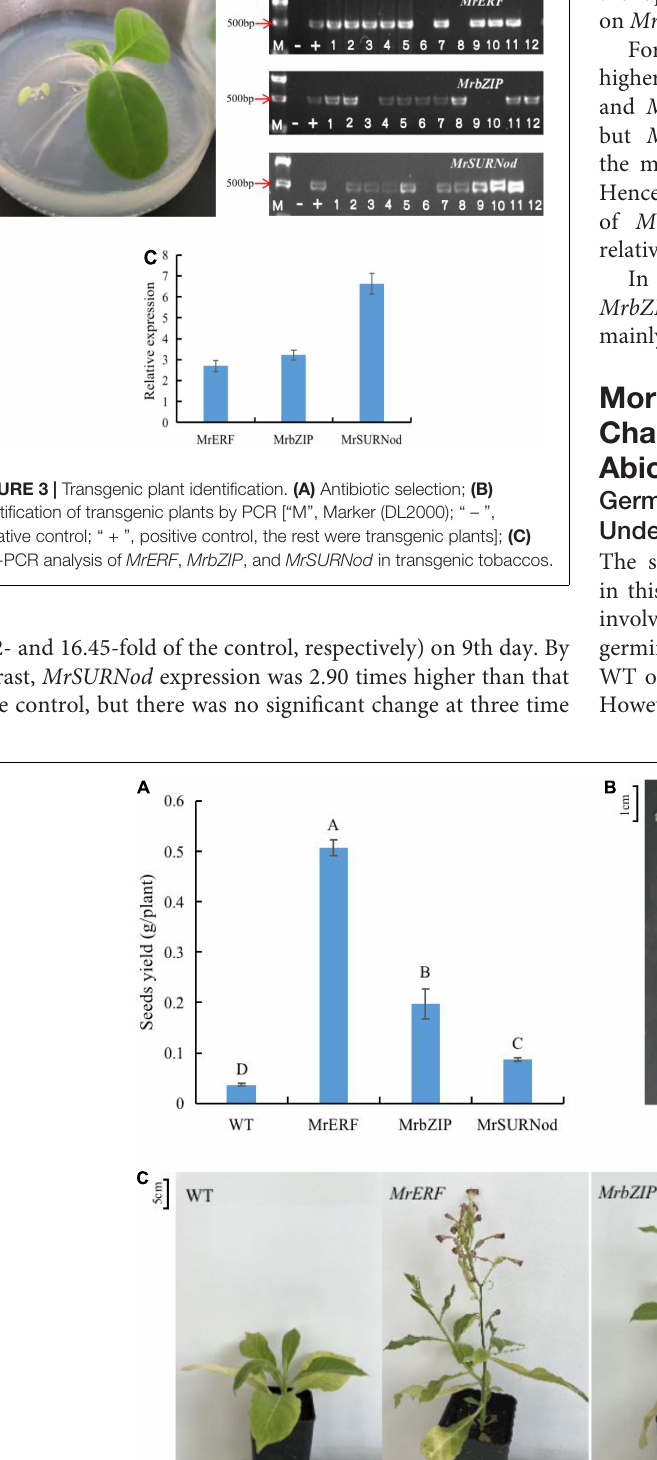
FIGURE 4 | Effects of MrERF , MrbZIP, and MrSURNod on plant growth. (A) Seed yield of different tobacco lines (Different capital letters in the figure indicate significant differences at 0.05 level among different transgenic treatments). (B) Root morphology of different tobacco lines. (C) Morphological characteristics of aboveground parts of different tobacco